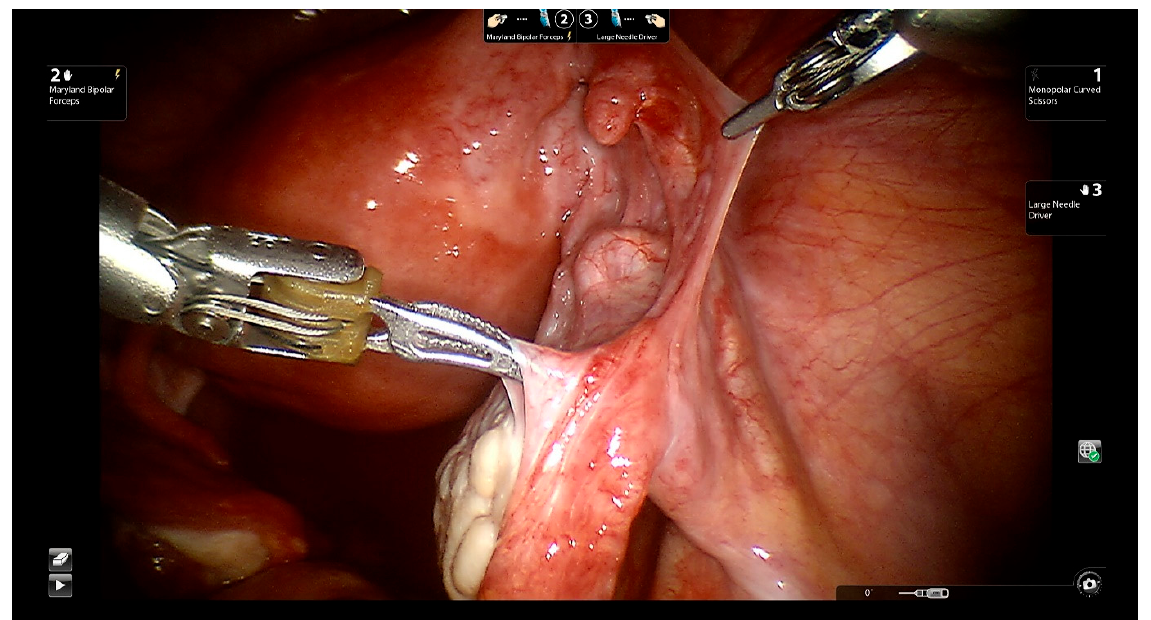
Figure 4. Exposing the distal and proximal ends of the fallopian tube. The surgeon injects indigo carmine dye transcervically, which permits him/her to identify the proximal portion of the tube and rule out obstruction of the proximal tube. Microscissors are then used to cut the muscularis-mucosal portion of the tube, and the proximal and distal ends are opened (Figure 5).